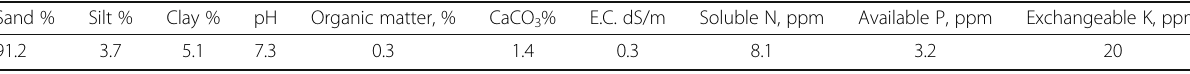
Table 1 Mechanical and chemical analysis of experimental soil Sand